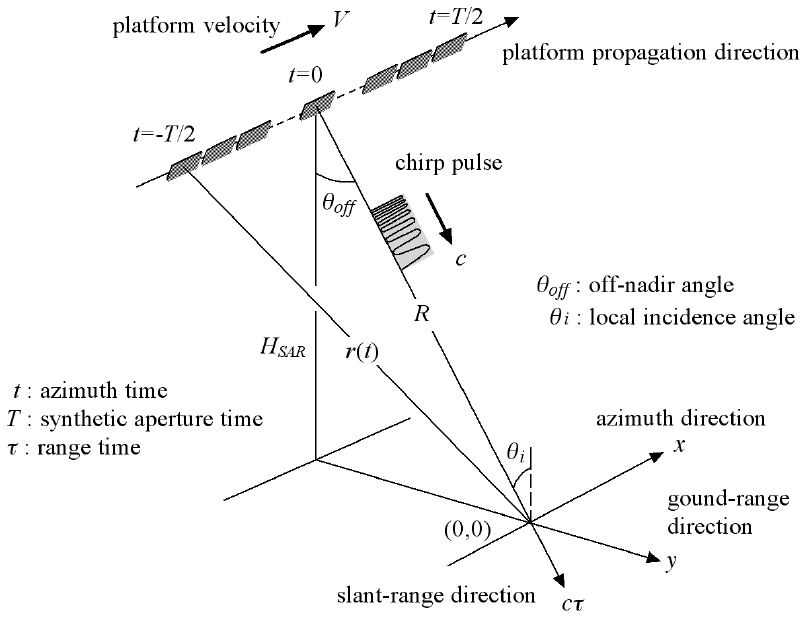
Figure 6. The geometry and terms of the SAR systems with the parameters used in this article. H is the height of the SAR platform, c is the velocity of the microwave, and r ( t ) SAR and R are respectively the slant-range distances at the azimuth time t and when the antenna is nearest to the target at the origin of the ground coordinate system ( x, y )